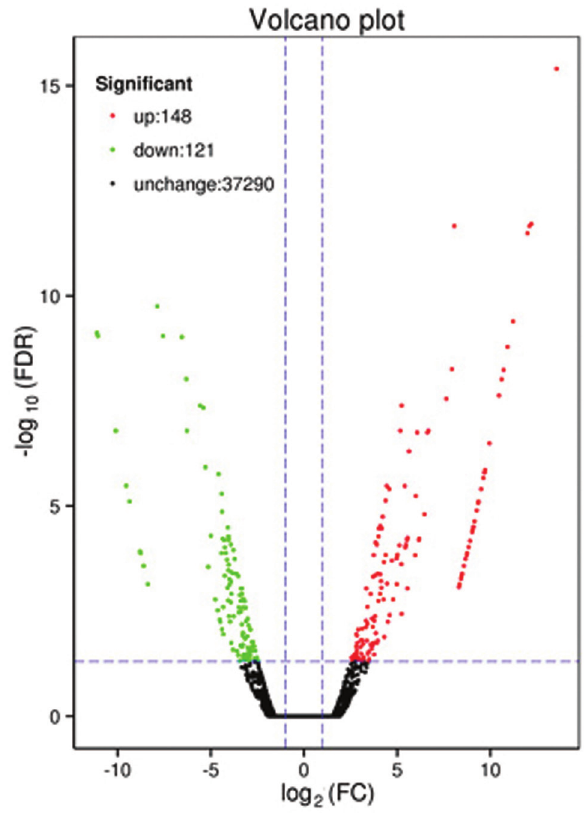
Figure 4 - Expression level of DEGs of 23-19 and eibi1 libraries . All Unigenes were examined for differences in their expression across the two samples. Red (up) and green (down) dots denote that the expression was significantly different (FDR (cid:7) 0.05, 2-fold difference) and the blank dots indicate no change between the expression levels in the two varieties.